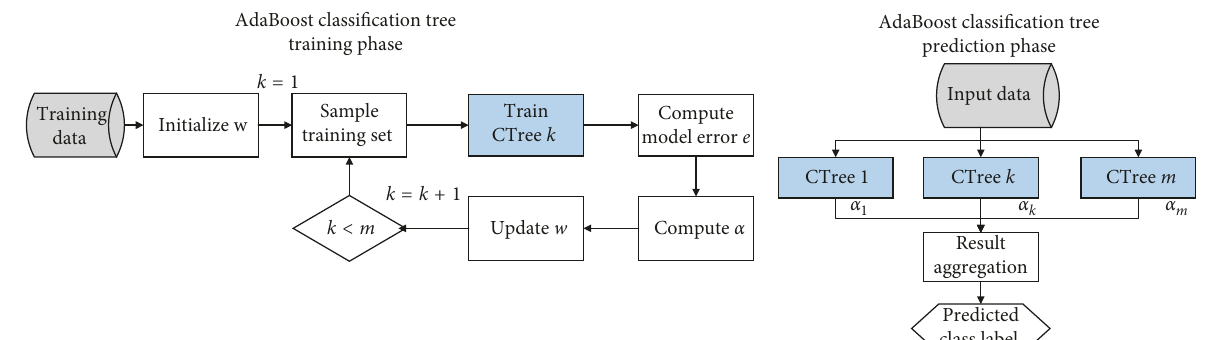
Figure 6: Adaboost CTree training and prediction